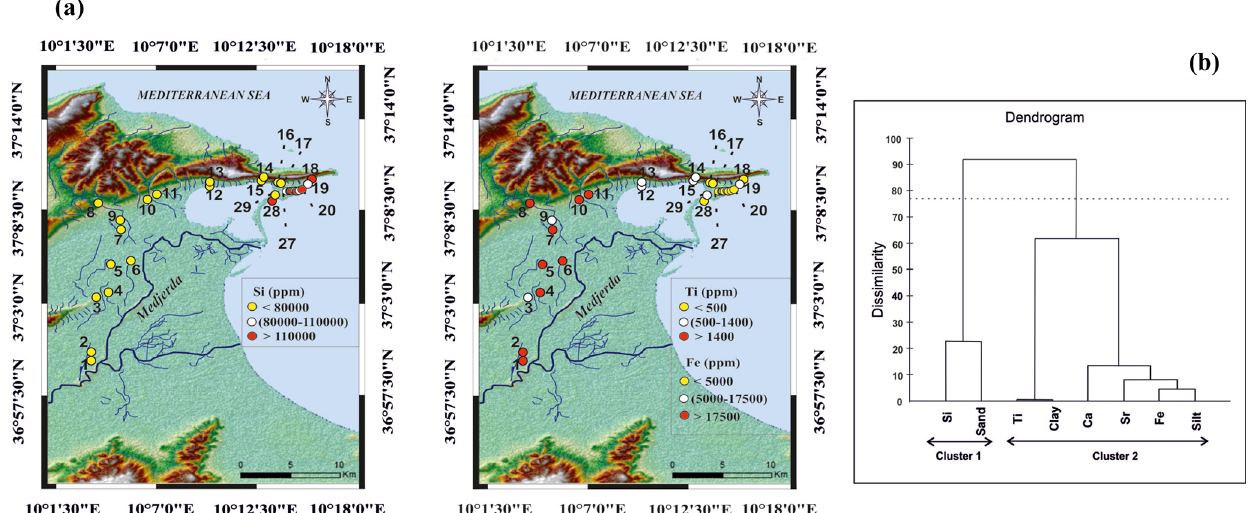
Figure 7. (a) Topographic maps of the iron (Fe), titanium (Ti), and silicon (Si) contents in the coastal plain of the Medjerda and around Ghar El Meleh lagoon (created by Radewane Hout using ArcGIS). (b) Cluster analysis of surface sediments around Ghar El Meleh